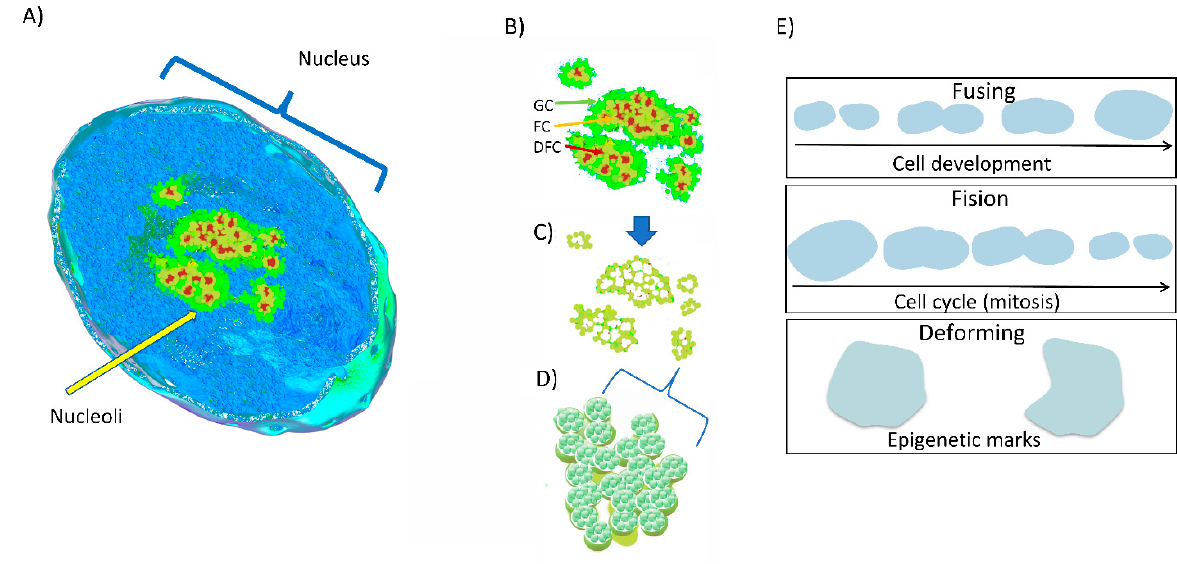
Figure 2. The multiphase structure of nucleolus. Our understanding of the behavior and composition of the nucleolus has been changed in recent years, as shown in ( A ) where key insights came from SIM and dSTORM wide field microscopy analysis to yield a more precise composition of the molecular crowded nucleolus. ( B ) shows key concepts regarding the LLPS behavior of the nucleolus. ( C ) Shows the ring-shaped structure organizing the components on ( B ). ( D ) Shows a close up of the elementary partition of each protein complex organizing the nucleolar hubs. ( E ) As biocondensates, the nucleoli can fuse to one another during cell development, can be broken into small hubs during mitosis, or change their form during specific epigenetic marks to coupling rRNA metabolism.